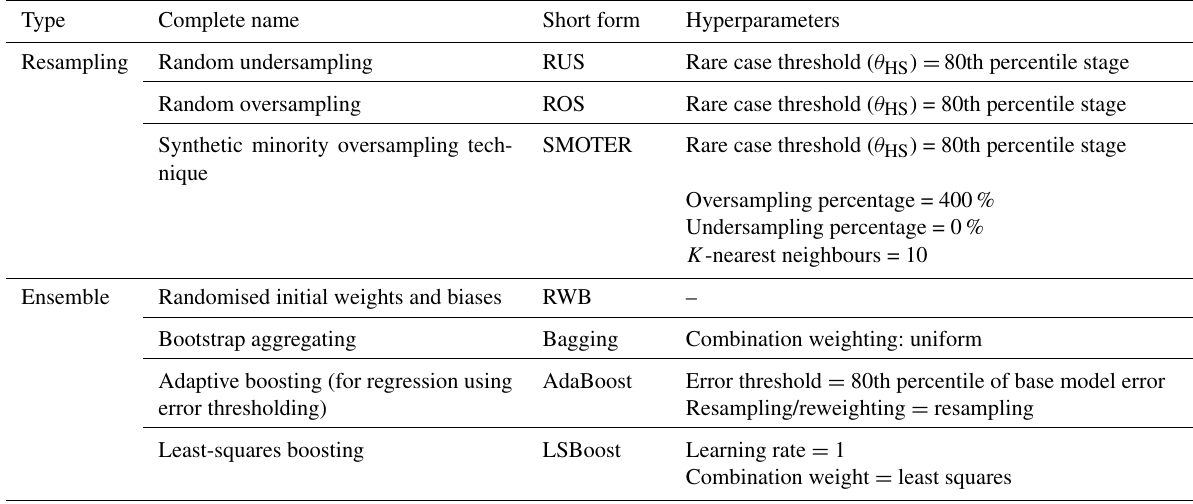
Table 4. Summary of ensemble methods and